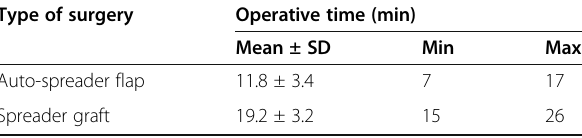
Table 1 Duration of operations conducted in this study Type of surgery